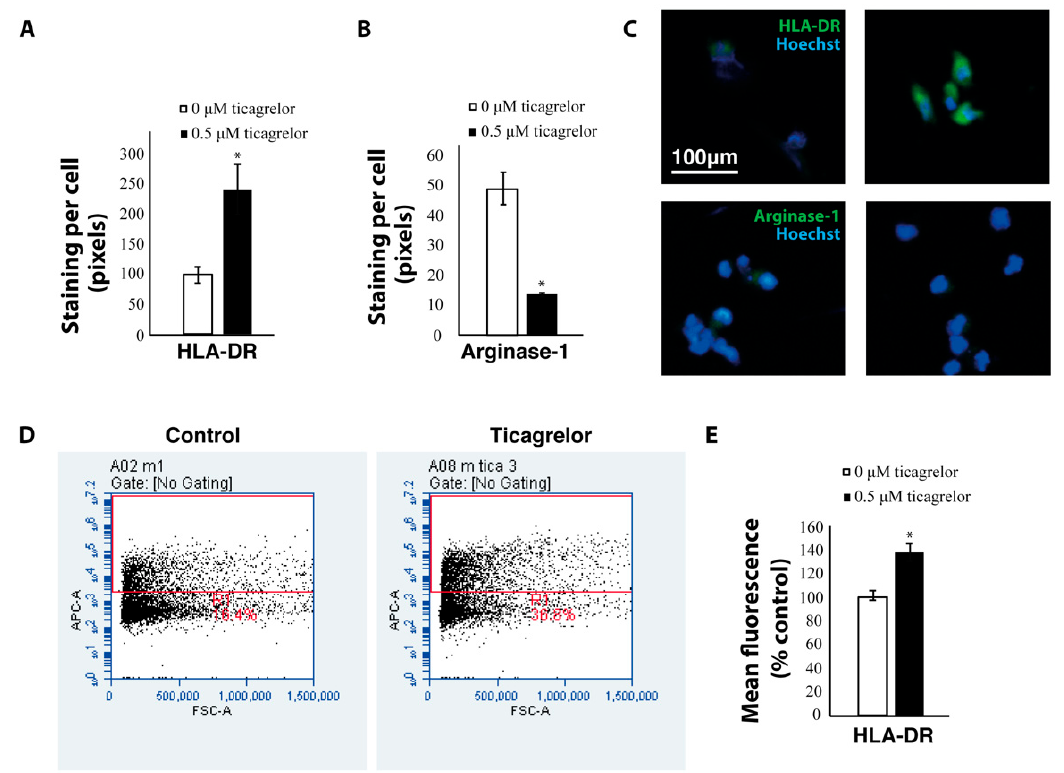
Figure 5. Ticagrelor increases the expression of anti-tumoral markers. ( A ) Area of positive staining with HLA-DR antibodies in THP1 macrophages treated with ticagrelor and controls. ( B ) Area of positive staining with arginase-1 antibodies in THP1 macrophages treated with ticagrelor and controls. ( C ) Representative images of THP1 macrophages stained with HLA-DR and arginase-1 antibodies. ( D ) Flow cytometry analysis of HLA-DR expression in THP1 macrophages treated with ticagrelor ( E ) Quantification of the flow cytometry analyses * = p < 0.05.